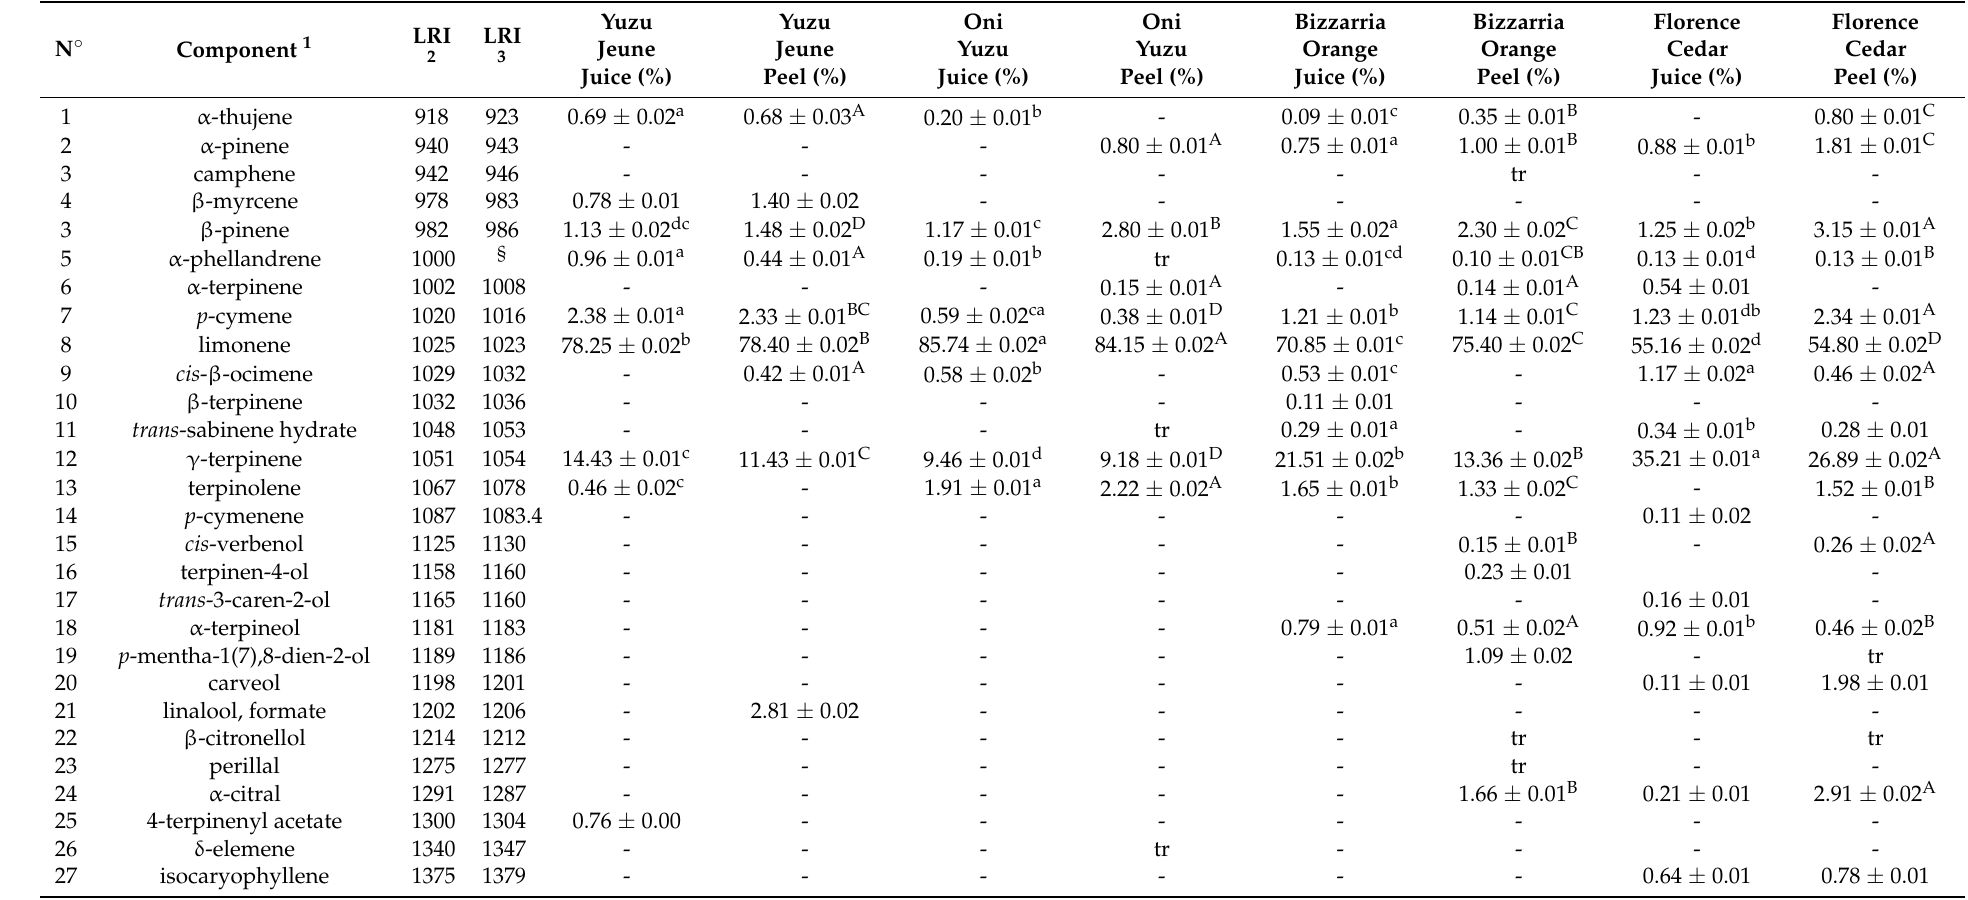
Table 1. Chemical composition (percentage mean value ± standard deviation) of vapor phase Yuzu Jeune, Oni Yuzu, Bizzarria orange and Florence cedar juice and